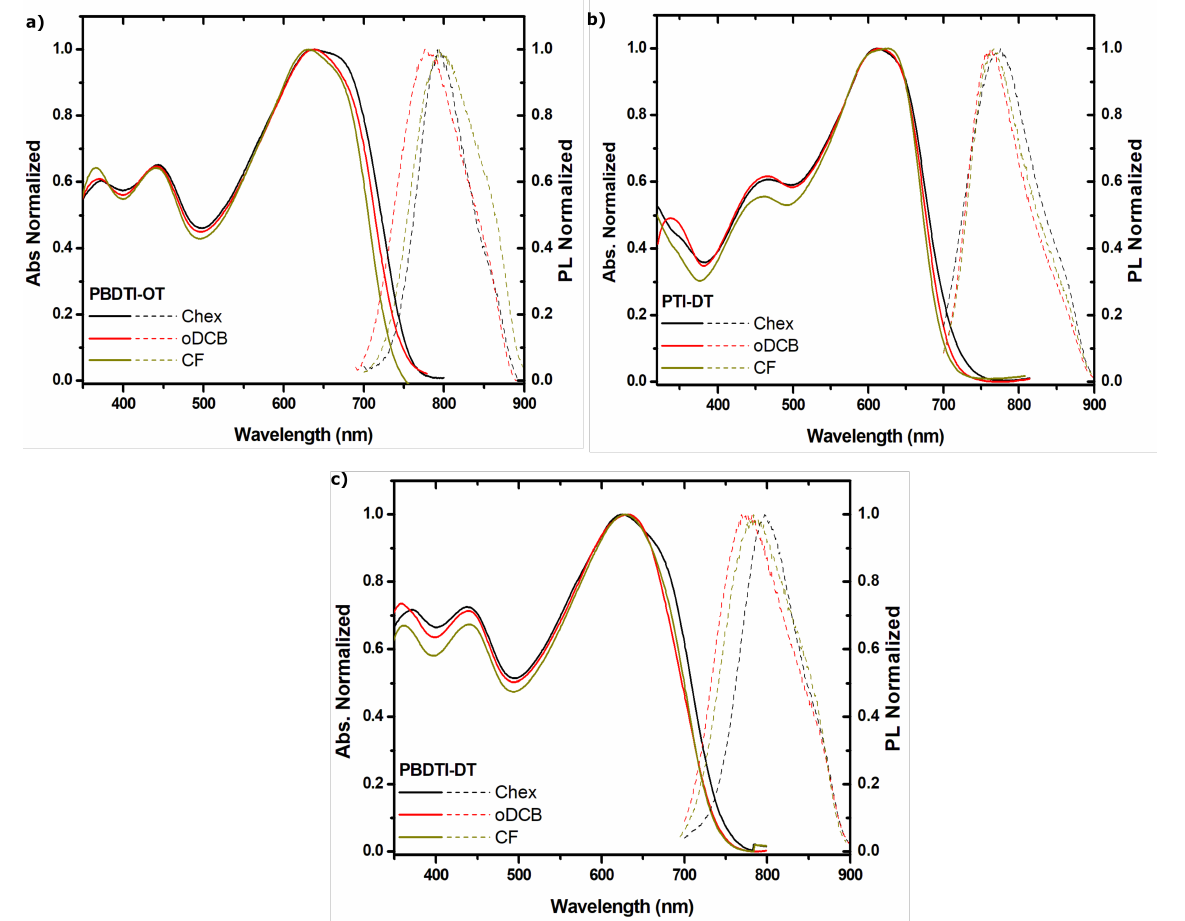
Figure 4. Absorption (solid line) and PL (broken line) of ( a ) PBDTI-OT , ( b ) PBDTI-DT and ( c ) PTI-DT in Chex (black), oDCB (red) and CF (dark yellow)